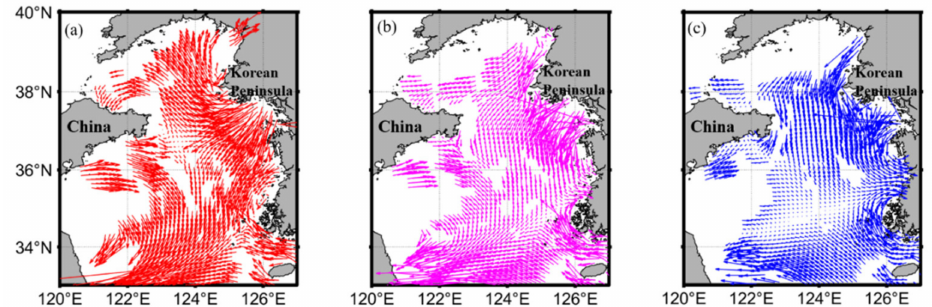
Figure 4. Tidal currents in the study area, based on OSU data. The red, magenta, and blue arrows indicate the changing directions of three tidal current field in continuous time. ( a ) The red arrows represent the flow field at 10:30 Beijing time; ( b ) the magenta arrows represent the flow field at 11:30; and ( c ) the blue arrows represent the flow field at